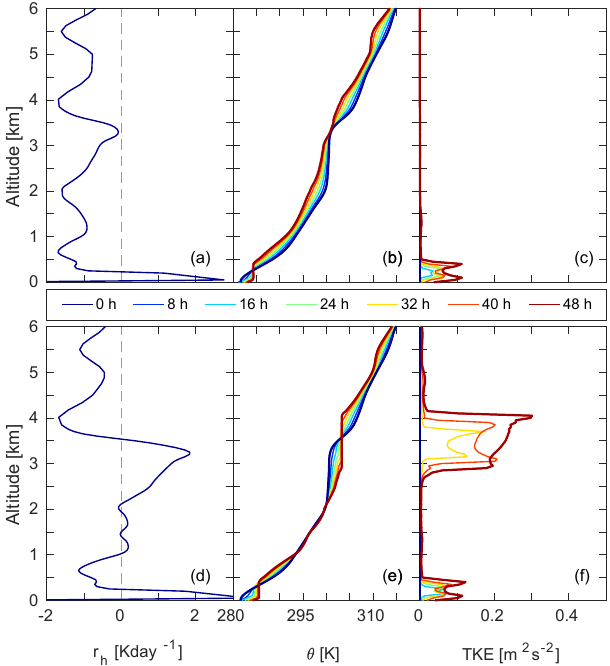
Figure 7. Vertical profiles of applied heating rate r h (a, d) , hori- zontally averaged potential temperature θ (b, e) , turbulent kinetic energy TKE (c, f) for simulations of a clean case (a–c) , and a pol- luted case with effects of aerosol load included (d–f) . Simulation data are stored at 8h